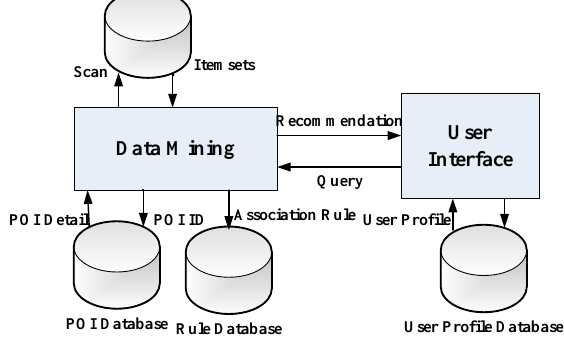
Figure 1. Route recommendation service model